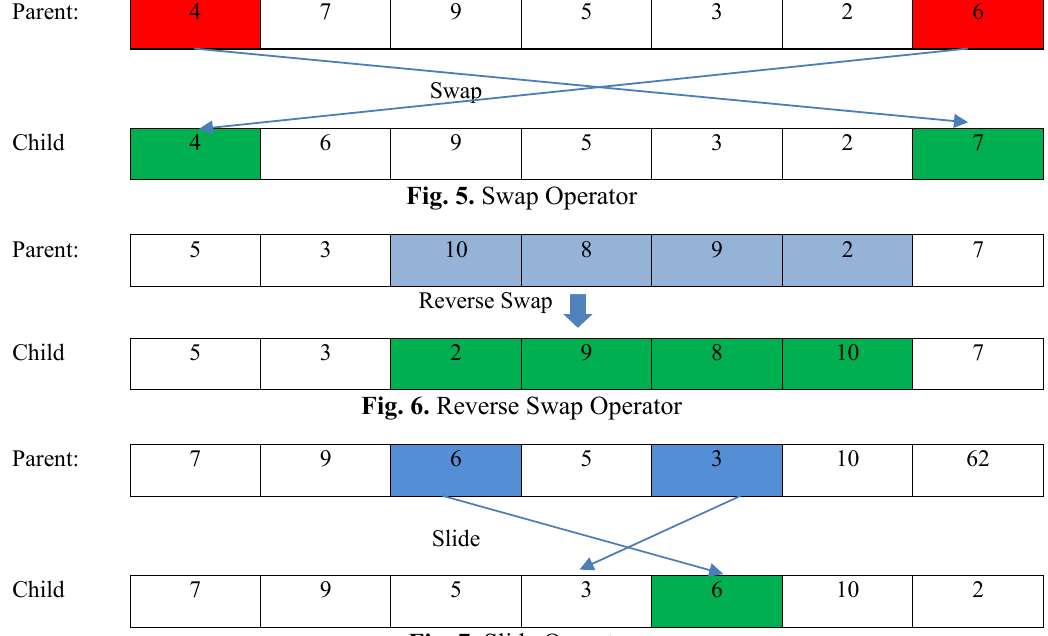
Fig. 6. Reverse Swap Operator